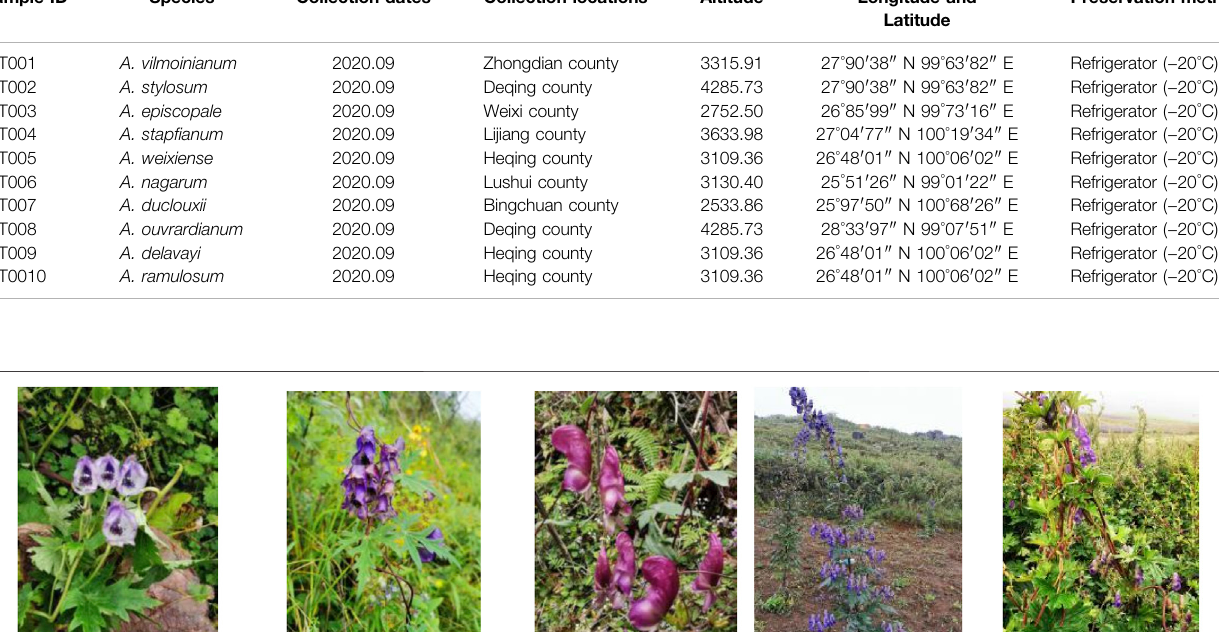
TABLE 1 | Information on the collection of ten Aconitum spp. Sample ID